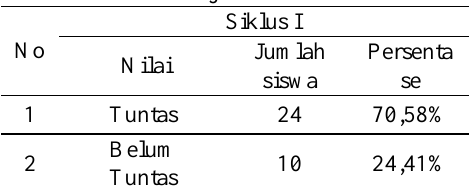
Tabel 2 . Distribusi Frekuensi Siklus I Nilai Mata